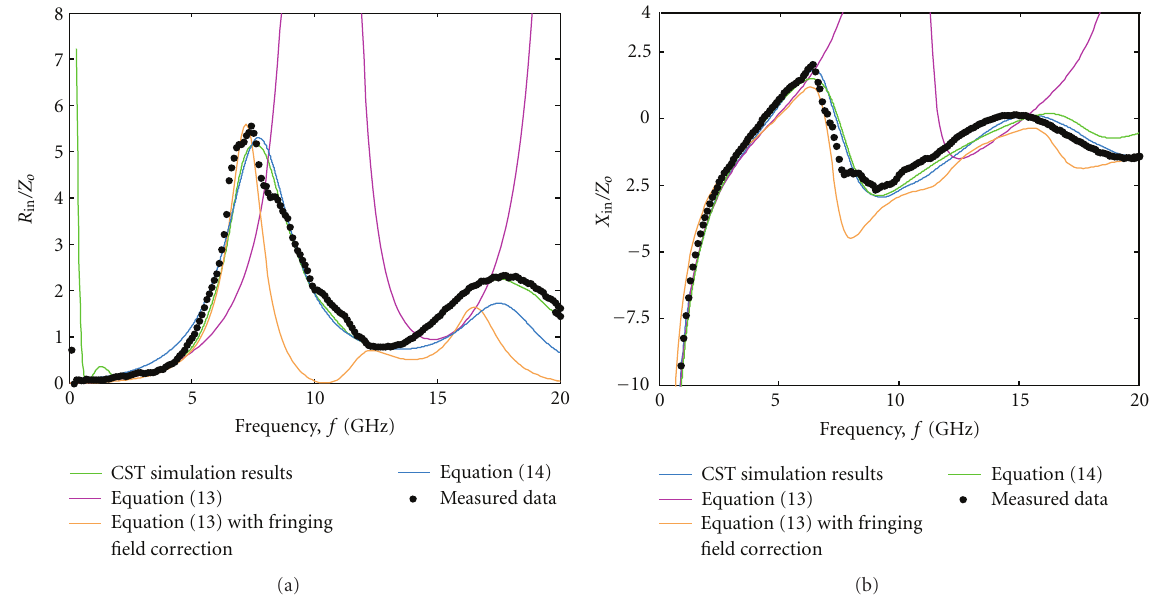
Figure 10: Comparison of (a) normalized resistance, R in /Z o , and (b) normalized reactance, X in /Z o , of the coupling monopole at excitation port-1 ( a = 0 . 65 mm, b = 2 . 05mm, h 1 = h 2 = 14 . 32 mm, and D = 10mm).